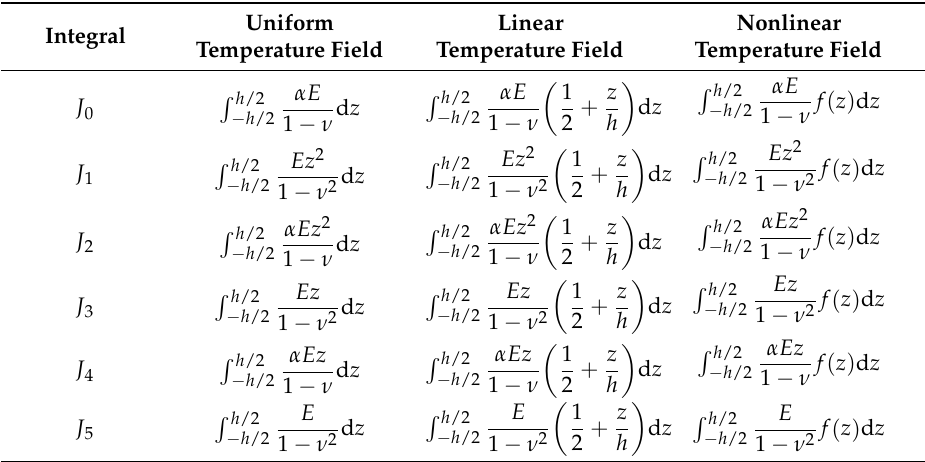
Table 3. The integrals in Equation (38).